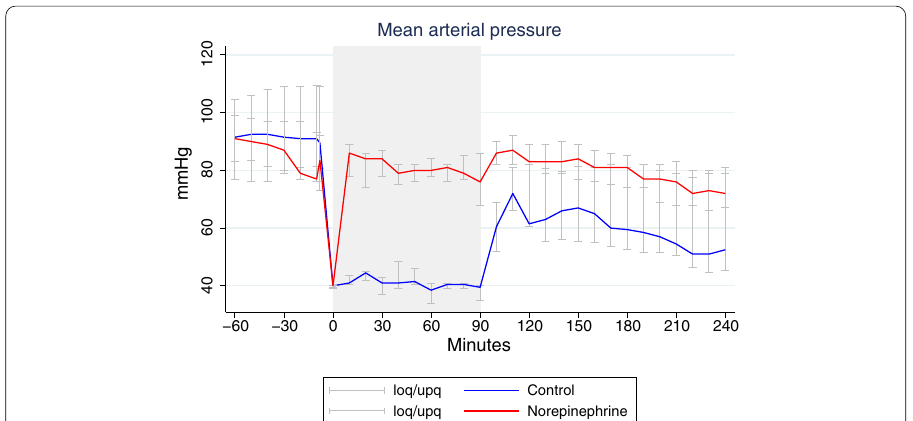
Fig. 2 Dynamic changes of median (interquartile range) mean arterial pressure (MAP) throughout the experiment. NE group n 8. Control group n 4. Note the steep decrease in MAP in both groups at the start = = of hypoperfusion period. In addition, note the normalisation of MAP after start of NE infusion. Shaded area